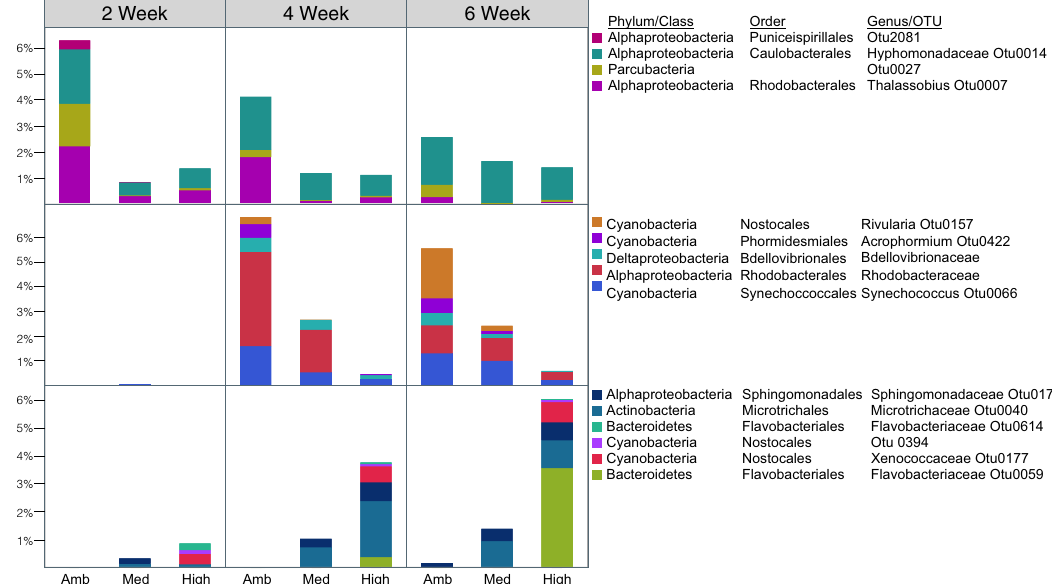
Fig. 6 Relative abundance patterns of coral-associated bio fi lm OTUs that responded to nutrients. At top are families with OTUs that associated with earlier time points and decreased with nutrient additions, in the middle are families with OTUs that are associated with later time points that decrease with nutrient additions, and at bottom are families with OTUs associated with later time points that increase with nutrient